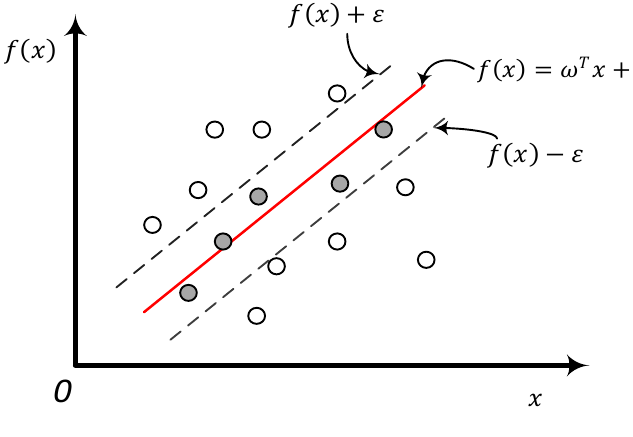
Figure 2. Support vector regression diagram.